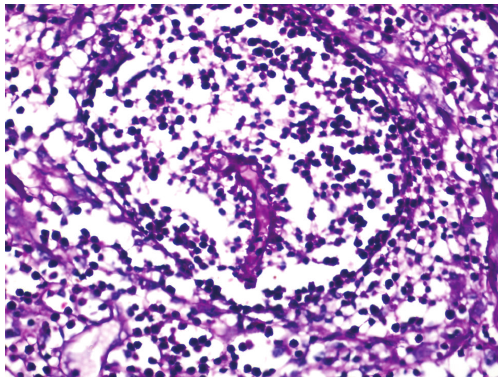
Figure 3: Photomicrograph showing aseptate fungal hyphal fila- ment on Periodic acid Schi ff (PAS, 400x),